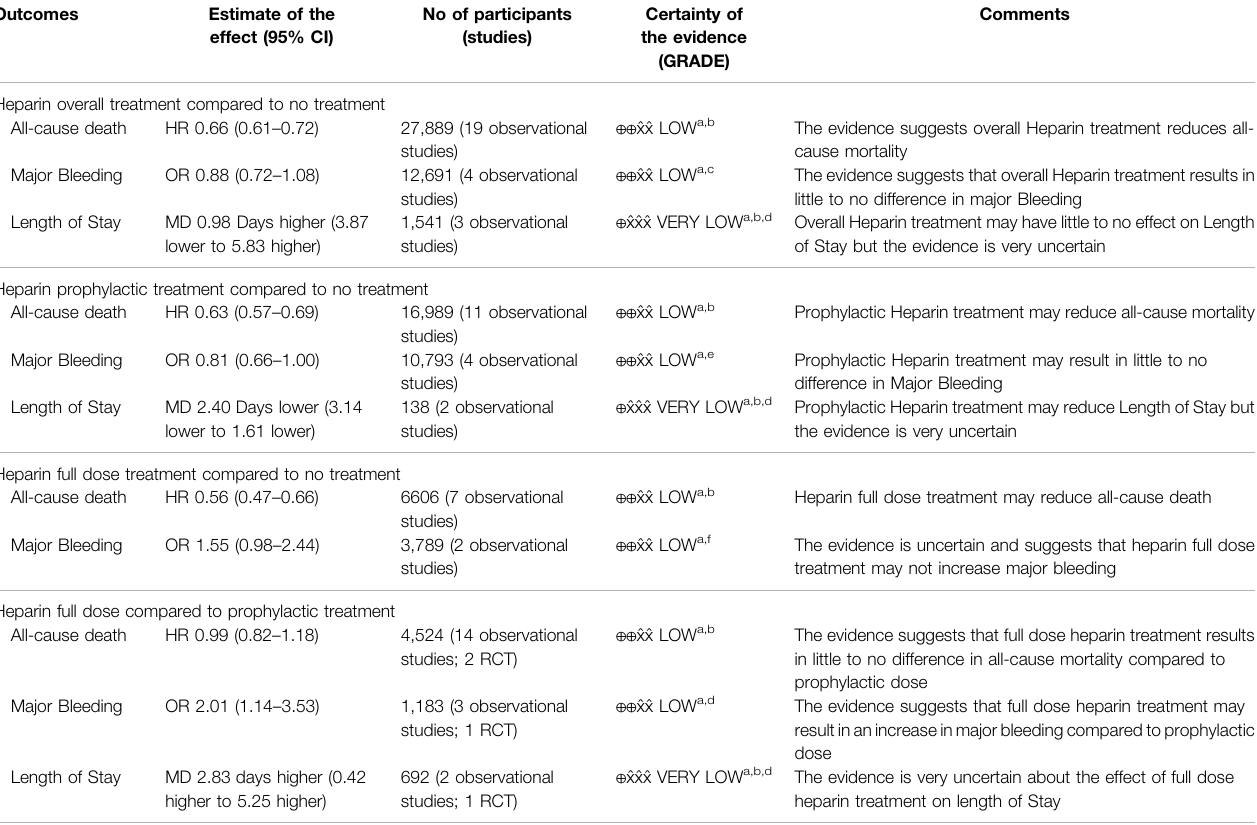
TABLE 3 | Summary of fi ndings and grading quality of the